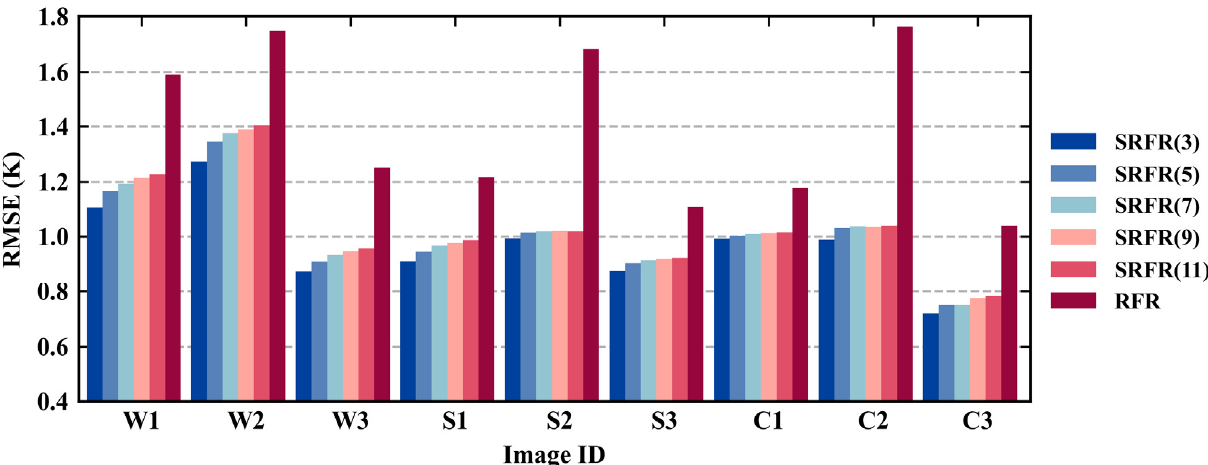
Figure 3. Random forest regression and spatial random forest regression models with different window sizes for spatial feature calculation of the LST. SRFR represents spatial random forest regression, RFR represents random forest regression, and the number in brackets represents the window size.